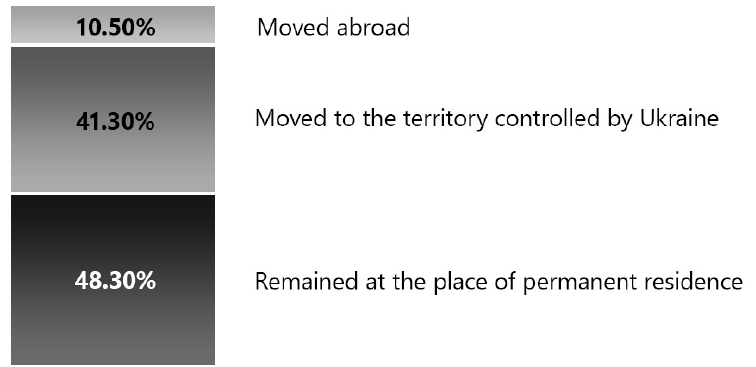
Figure 2. Distribution of respondents by place of